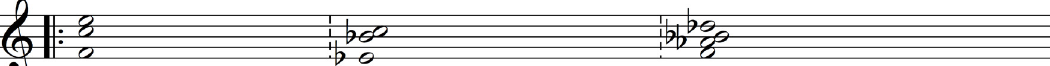
Figure 2. Three chords transcribed from trio